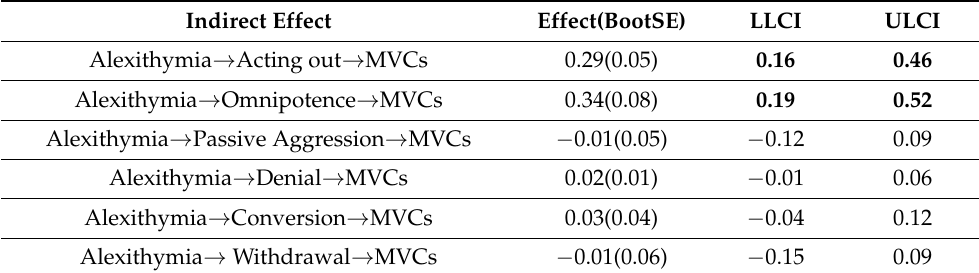
Table 4. Indirect effects of adolescents’ alexithymia on motor vehicle collisions through